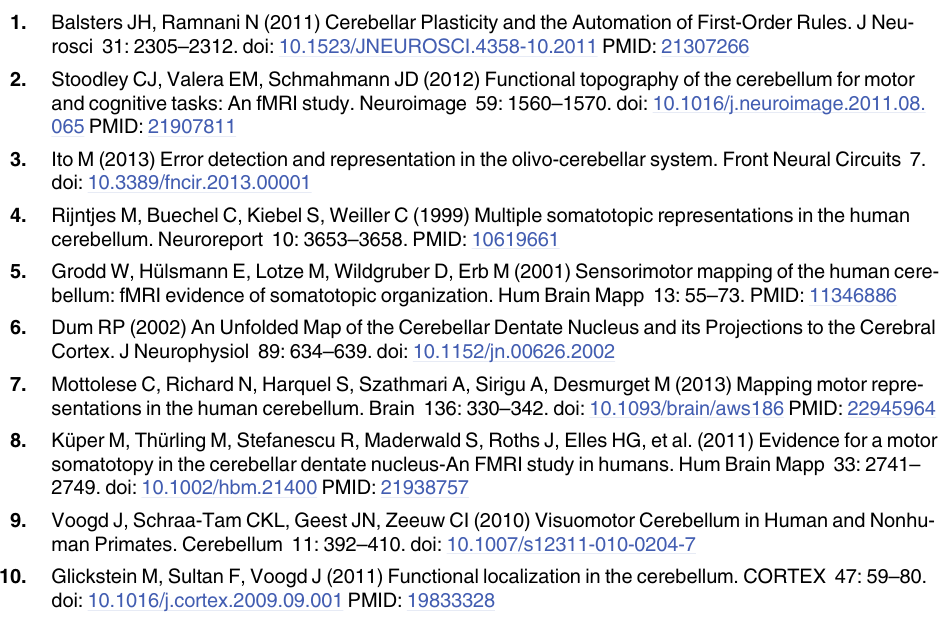
(bottom left) panels. Refer to Fig 1a for a guide to anatomical lobule definitions. (TIF) S3 Fig. Signal Strength and Activation Loci. T maps (Funct) and tSNR from a single PA run are overlaid on the T1w structural scan from one subject and aligned with the T2 (cid:1) w (T2 (cid:1) ) structural images for six Cb ROIs (L and R paravermis VI, OMV, L paravermis VIIb, and R h VIIb and R h CrusII), indicated by crosshairs. It is clear that significant changes in BOLD sig- nal are not restricted to areas with higher tSNR (yellow-white regions of tSNR images) nor do they occur spuriously around Cb vasculature (dark dots in the T2 (cid:1) w images). Slice locations (in non-normalized MNI space) are displayed at the top of each Funct panel and coordinates are the same for all three images. T-values and tSNR strength at the crosshairs are displayed at the bottom of the axial (rightmost) panels. Refer to Fig 1a for a guide to anatomical lobule defi- nitions. S1 Table. Adaptive Cluster-Based (AT) versus SPM Voxel-Based (SPMT) FDR-Corrected Thresholds. NM — Normalised and Smoothed. (cid:1) Thumb was tapped during the ENTIRE ses- sion (no rest period), so FT was not compared between head and surface